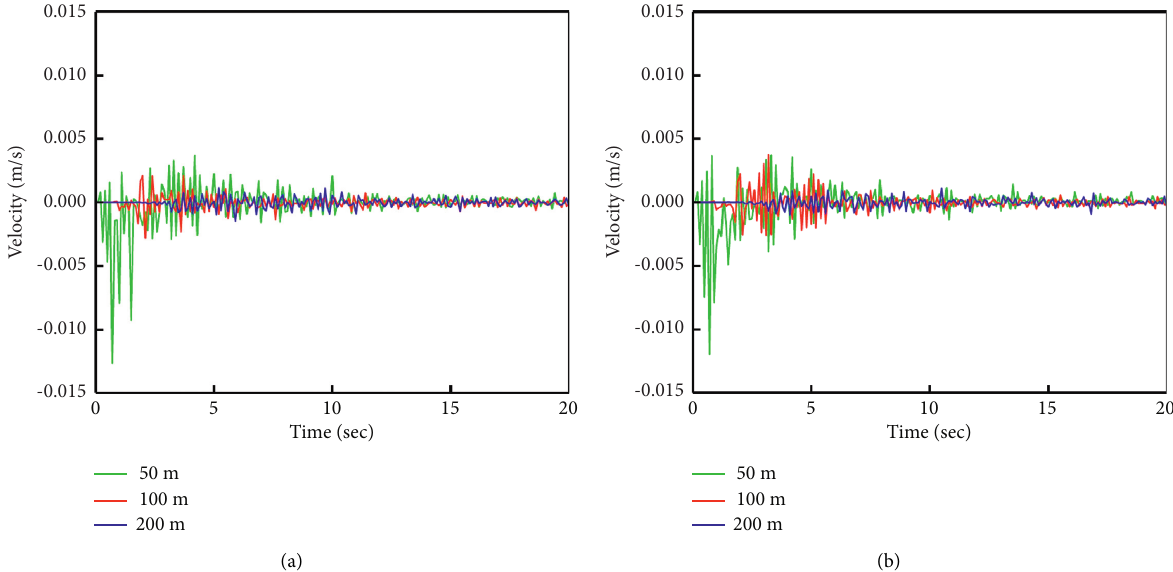
Figure 17: Comparison of the peak vibration velocities for the three-hammer condition at different times (m/s; for the quincuncial arrangement): (a) 1 s, (b) 2s, and (c) 4 s.